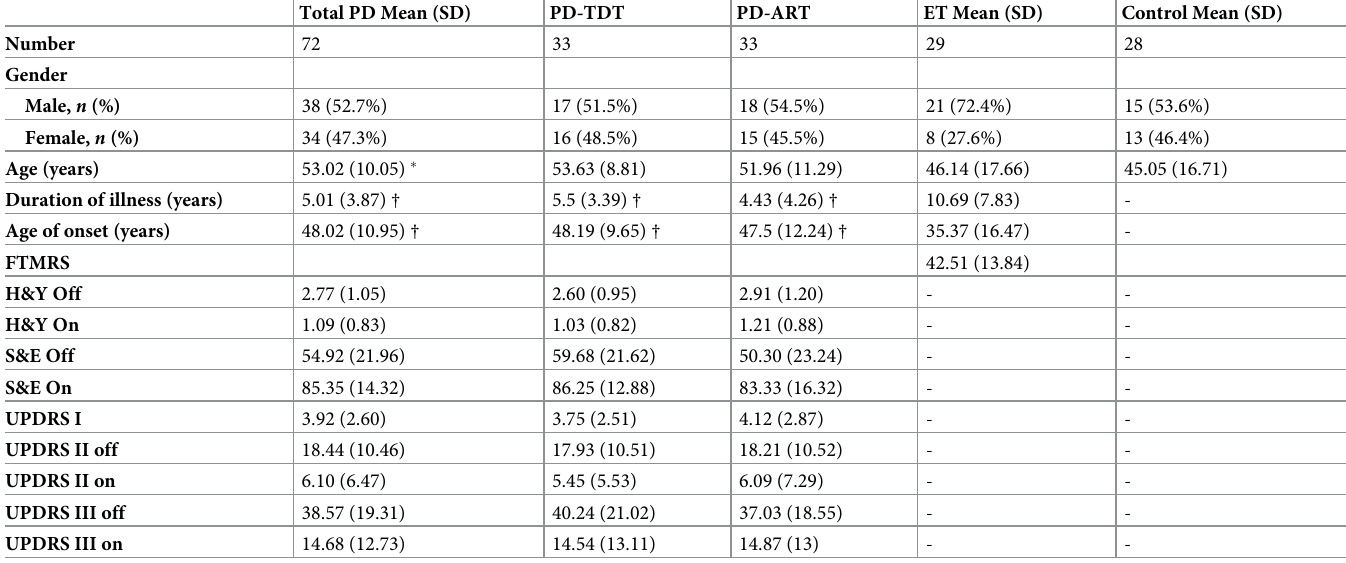
Table 1. Demographic and clinical characteristics of the study population.